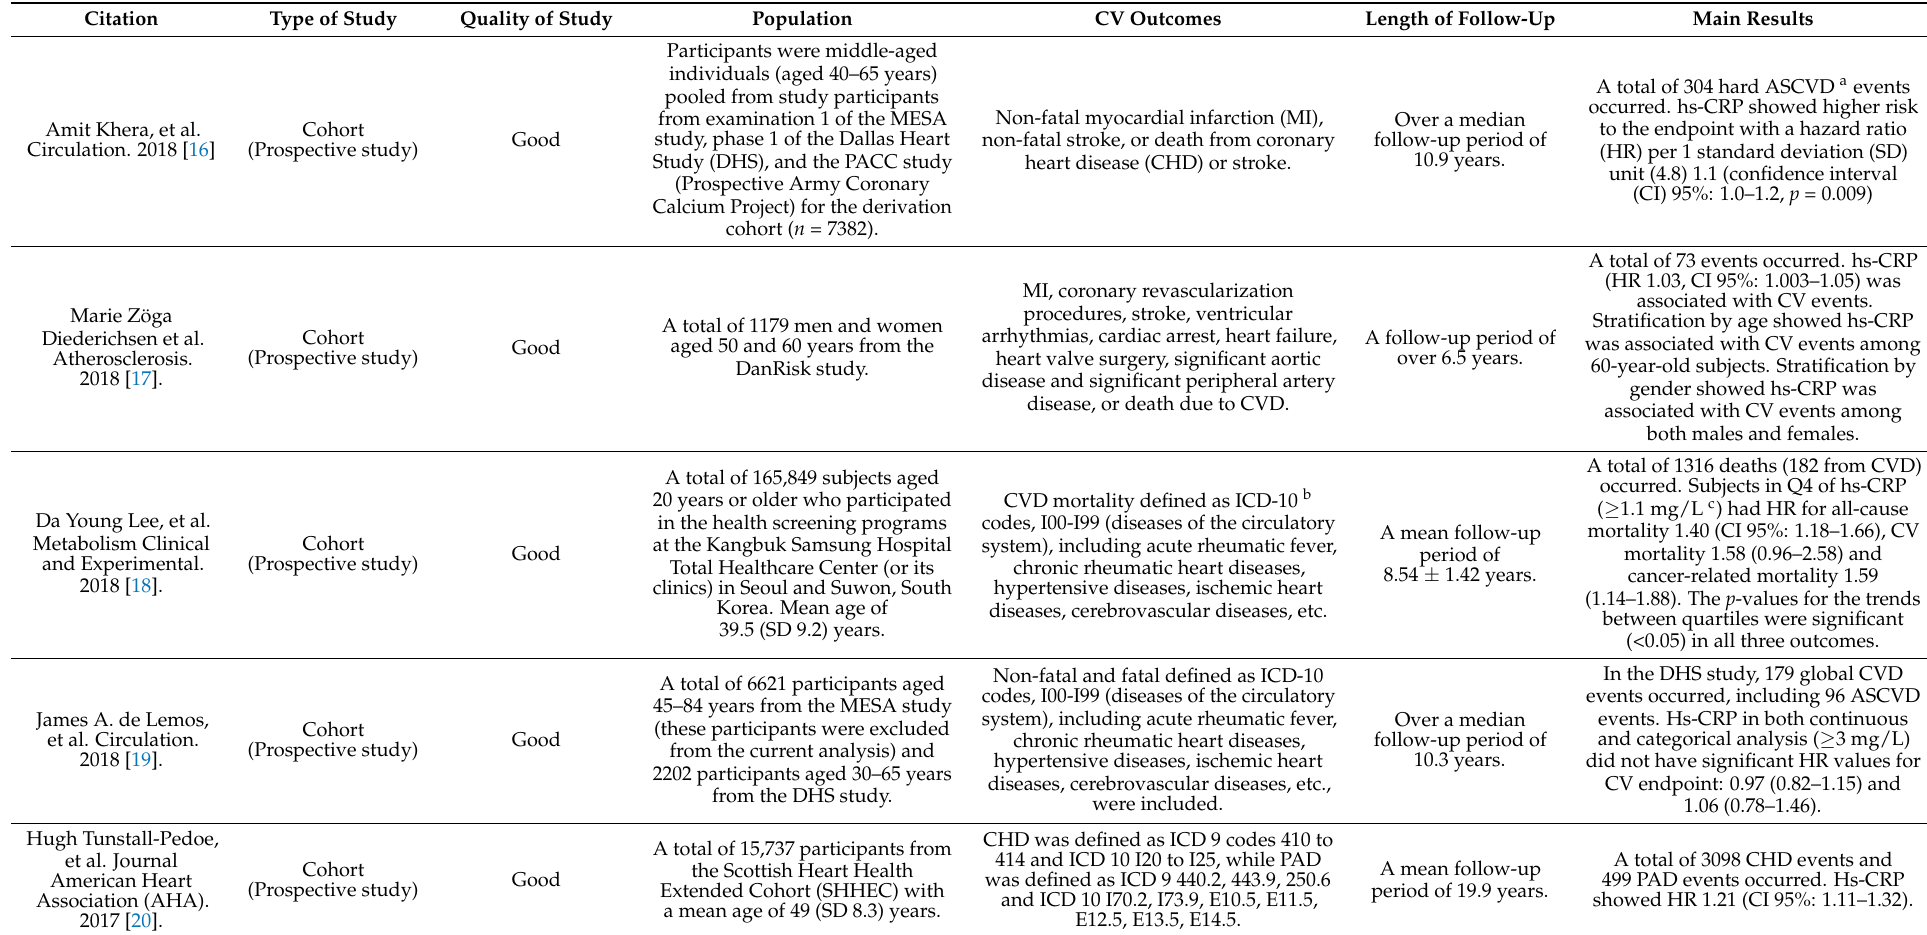
Table 1. Studies assessing high-sensitive C reactive protein